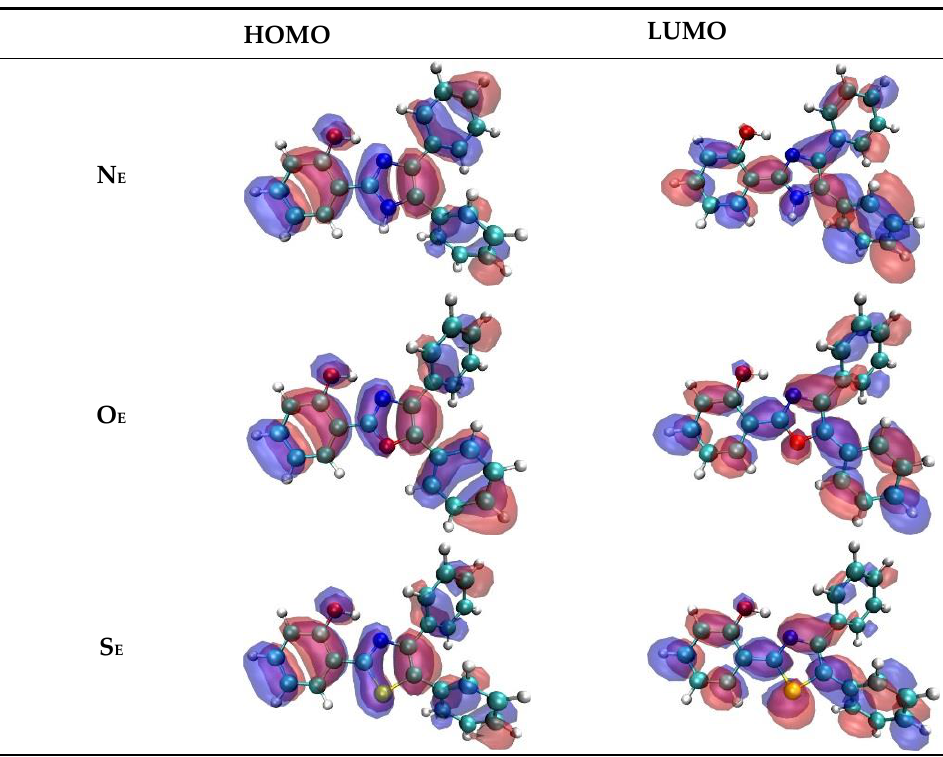
Figure 6. Molecular orbitals HOMO and LUMO for N E , O E , and S E , respectively.